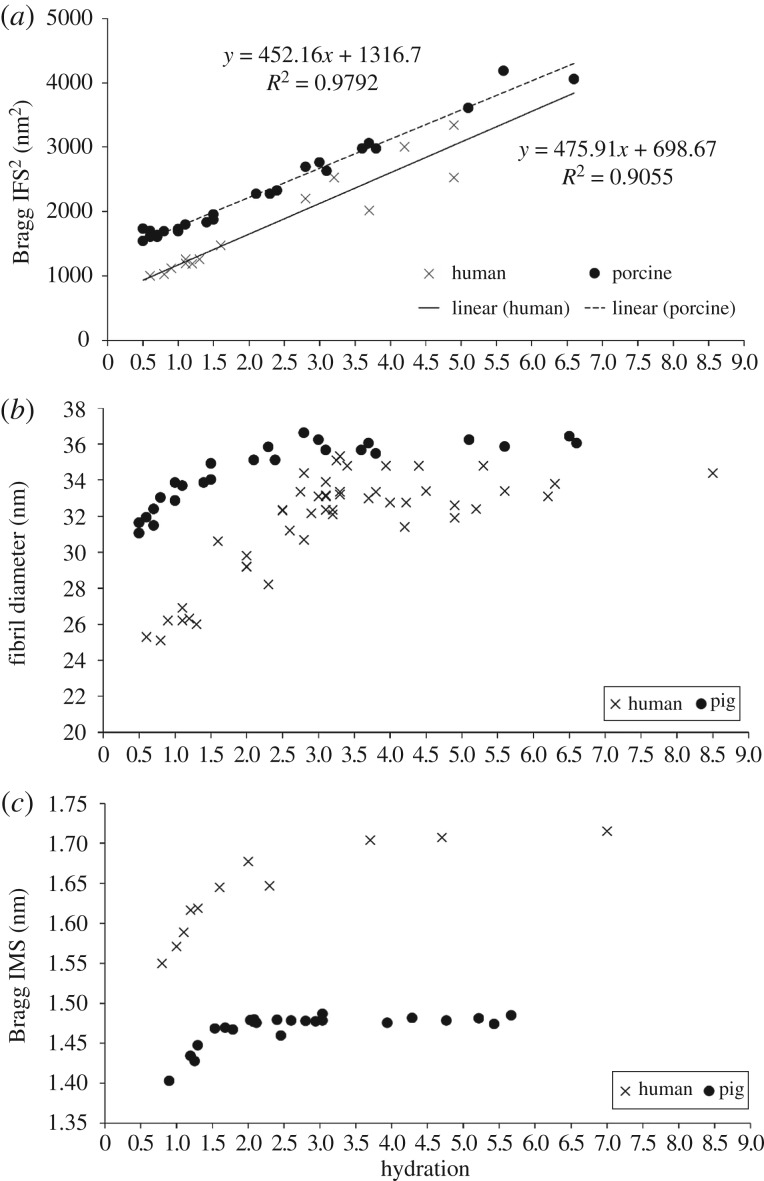
Structural transformation of the human and porcine corneal stroma with PEG adjusted hydration. The relationship between hydration and the square of the corneal collagen Bragg interfibrillar spacing (IFS2) (a), fibril diameter (b) and intermolecular spacing (IMS) (c) for PEG-equilibrated human and porcine corneas. See the electronic supplementary material, S3 for tabulated data format.